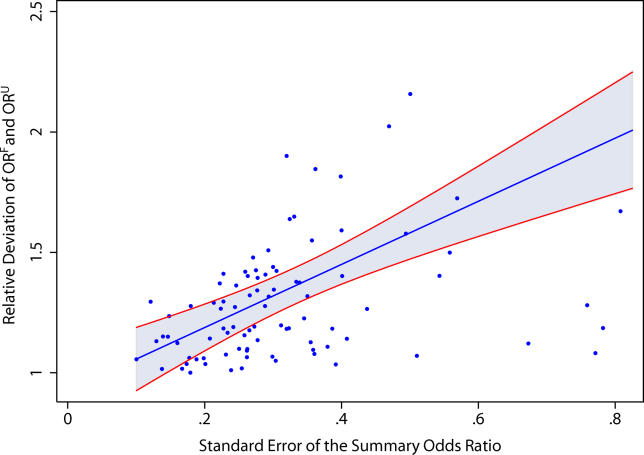
Relative Deviation of the OR with Two Designs as a Function of the Standard Error of the Summary ORThe continuous bold line is the fit unweighted linear regression, and the shaded boundary presents the 95% CIs. Four outliers are not shown.